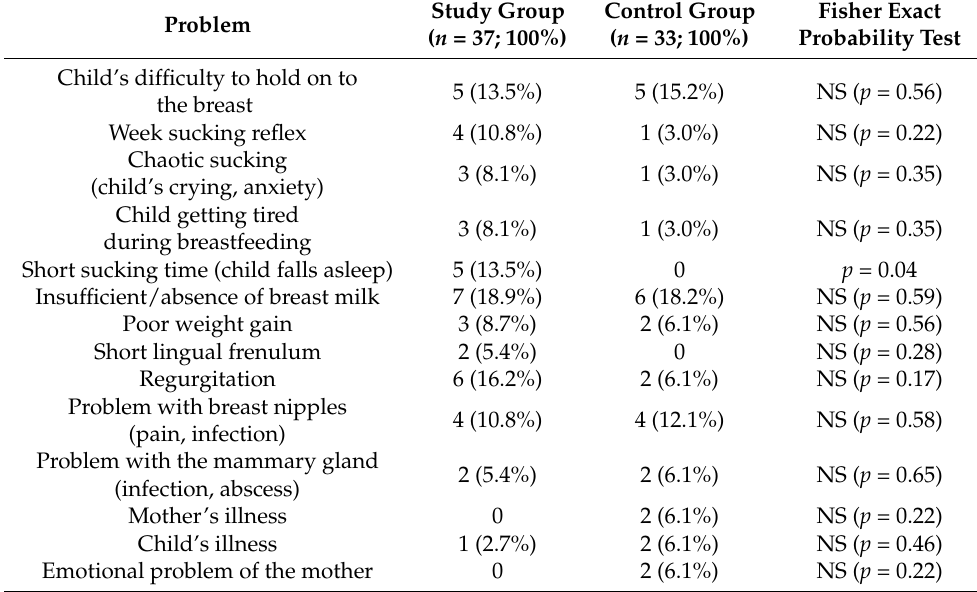
Table 3. Types of problems during breastfeeding experienced by the mothers in the study and the control group (question